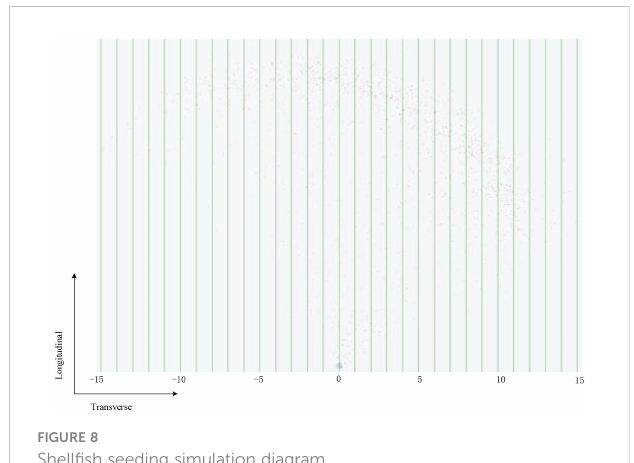
FIGURE 8 Shell fi sh seeding simulation